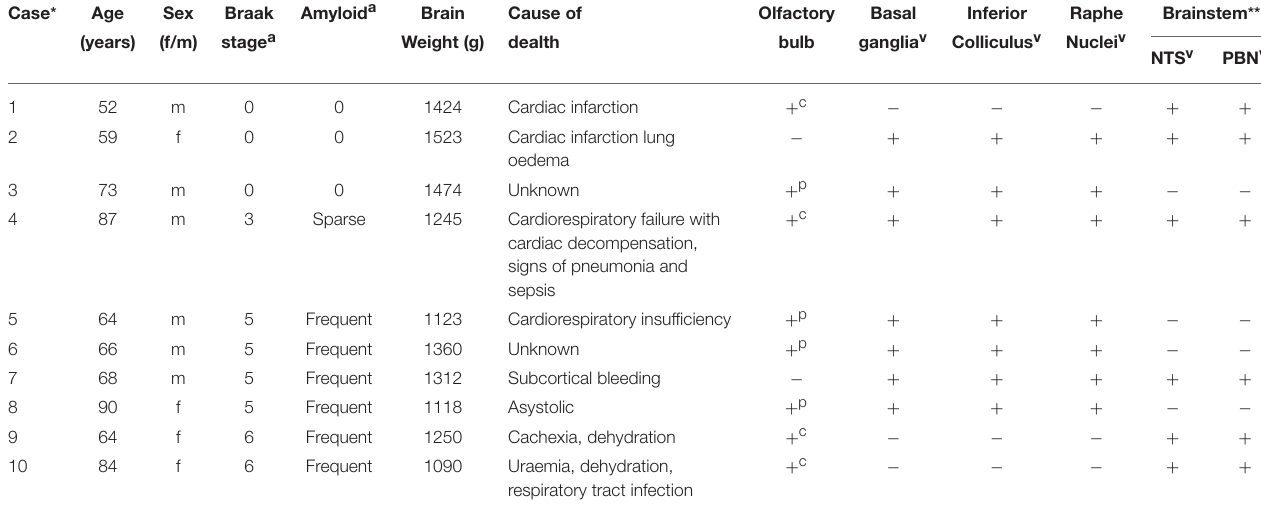
a, based upon examination of temporal cortex and hippocampus. p, paraffin-embedded sections of the olfactory bulb and olfactory cortex (8 µ m). c, cryostat sectioned olfactory bulb and olfactory cortex tissue (10 µ m). v, Vibratome sectioned brain tissue (50 µ m). * All patients had a postmortem delay between 24 and 48h and a fixation time of at least 3 months. ** Brainstem data reported in Irmler et al. (2012). − , no tissue